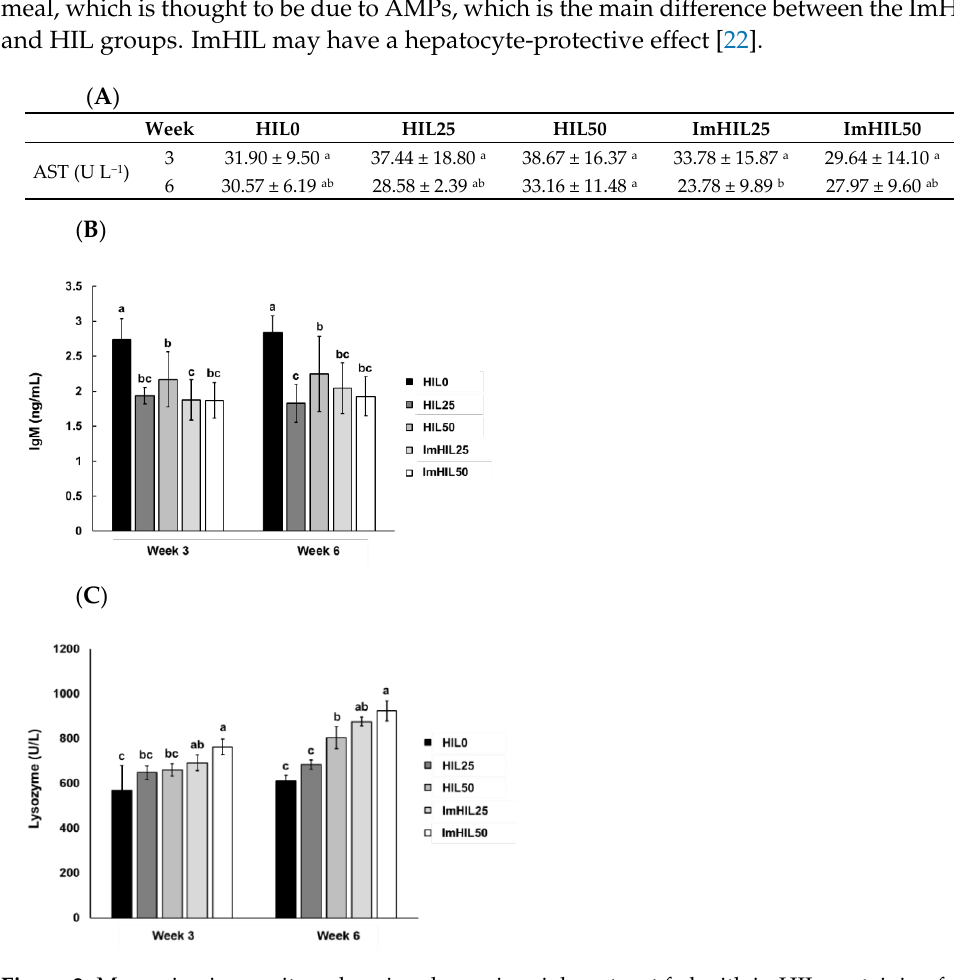
Figure 3. Measuring immunity-enhancing degree in rainbow trout fed with imHIL-containing feed. Aspartate aminotransferase (AST) ( A ), lysozyme activity ( B ), and immunoglobulin M (IgM) ( C ) were quantitatively analyzed. Initial AST level of rainbow trout blood serum was 67.57 ± 16.72 U L − 1 . Values are means ± standard deviations of triplicates. HIL0, 0% HIL; HI25, 25% normal HIL inclusion as fishmeal weight basis; HIL50, 50% normal HIL inclusion as fishmeal weight basis; ImHIL25, 25% immunized HIL inclusion as fishmeal weight basis; ImHIL50, 50% immunized HIL inclusion as fishmeal weight basis. Vertical error bars denote standard error of mean, and alphabetic characters represent significant differences ( p < 0.05) among each group at week 3 and week 6 as determined by Duncan’s multiple range test, respectively ( n = 9, 3 tanks, 3 fish per tank).